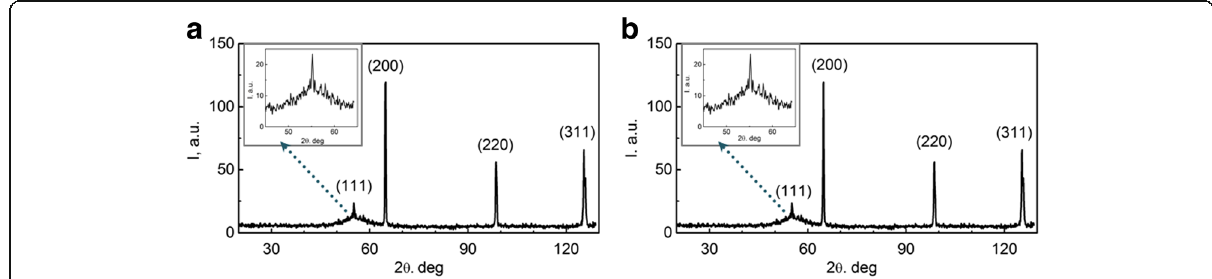
Fig. 6 X-ray diffraction patterns of a Fe-Co-W and b Fe-Co-Mo coatings with thickness of 30 μ m on copper substrate